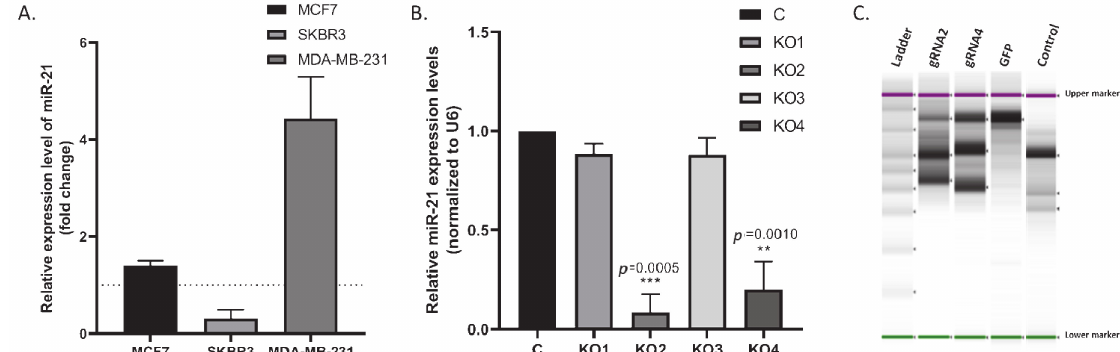
Figure 2. ( A ) miR-21 expression levels were analyzed by qRT–PCR in MCF-7, SKB3, and MDA-MB-231 cells. The column graphic represents the average of three replicates of RNA isolated from each cell line. Data normalized according to RNU6 expression level by fold analysis ( n = 3; p < 0.005). ( B ) miR-21 knockout MDA-MB-231 cell colonies confirmed by qRT–PCR assay. The column graphic represents the average of three replicates of RNA isolated from each cell line. miR-21 expression levels of miR-21 knockout clone 2 (KO2) and miR-21 knockout clone 4 (KO4) cell colonies were downregulated significantly compared to untreated control MDA-MB-231 cells ( n = 3; p = 0.005 and 0.001, respectively). ** p = 0.0010, *** p = 0.0005. ( C ) genomic cleavage Assay TapeStation results indicating CRISPR/Cas9 efficiencies of 83.11% (gRNA2) and 75.37% (gRNA4) in comparison with GFP control (0%) and assay commercial’s control (0%). Fragments size: 25 bp lower marker, 1500 bp upper marker. ≈ 860 bp non-cleaved product, ≈ 540 bp cleavage product 1 and ≈ 320 cleavage product